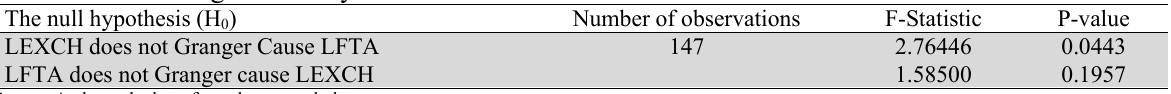
Results of the Granger causality test The null hypothesis (H 0 ) Number of